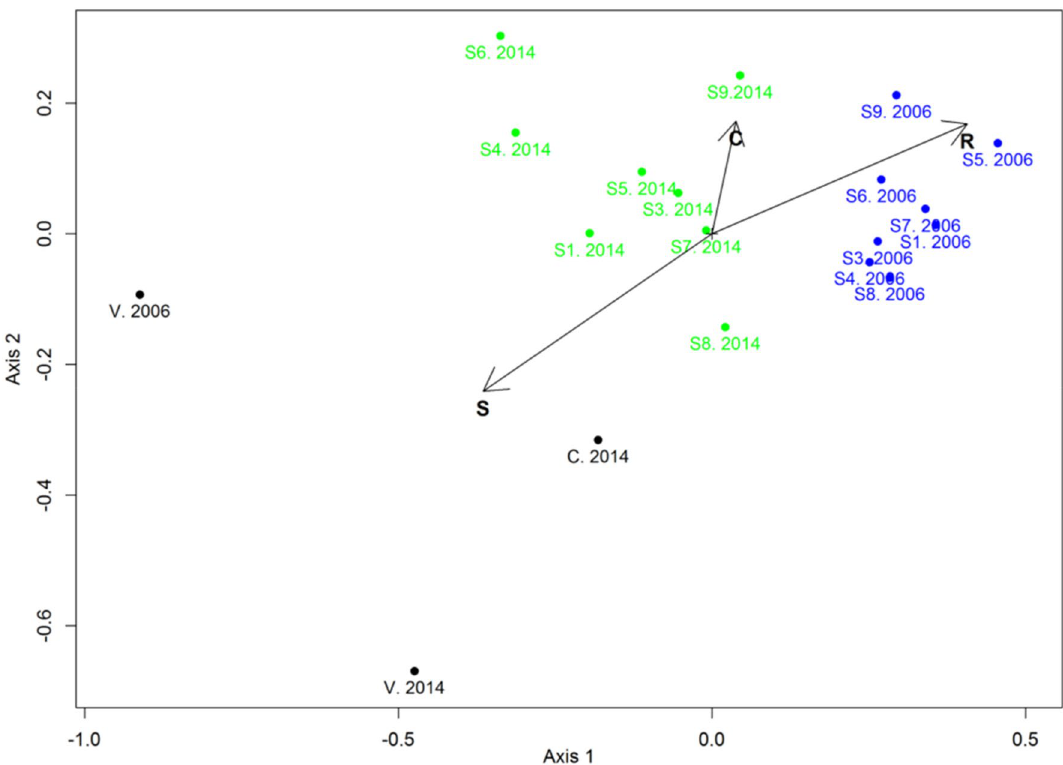
Figure 4. Non-metric multidimensional scaling (NMDS) ordination of relevés based on Bray–Curtis distance for experimental (S1 to S9), control (C), and reference (V) plots. Experimental plots from 2006 (blue) and 2014 (green). Control and reference plots 2014 (black).